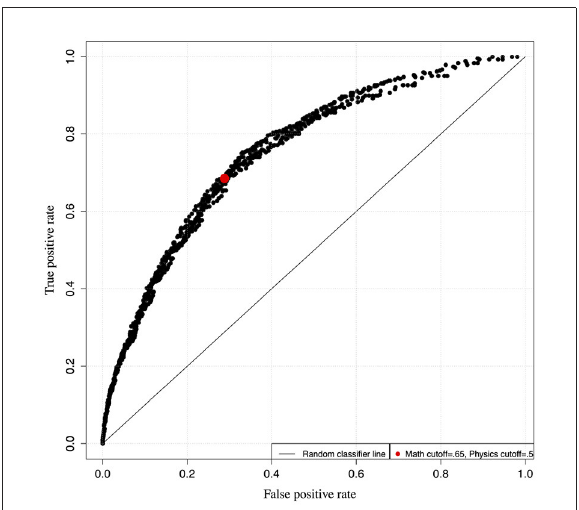
FIGURE2 Receiver operating characteristics (ROC) curve for Satisfactory (S)/Unsatisfactory (U) grades in Physics I by predicted risk categories for Fall 2006–2010